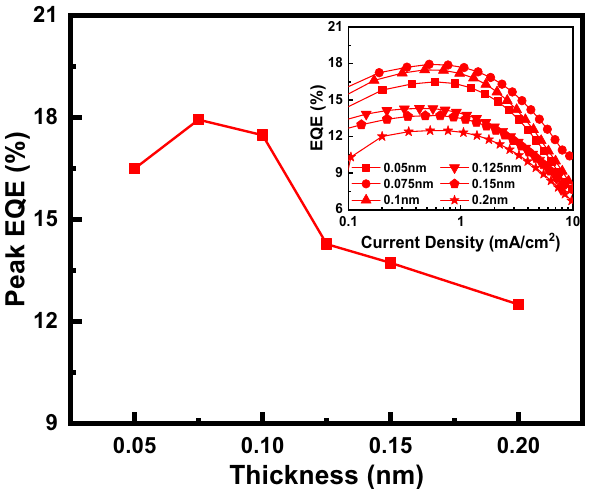
Figure 2. Peak EQE versus thickness of Ir(ppy) 3 from 0.05 to 0.2 nm. The inset shows the EQE characteristics of the fabricated OLEDs, as a function of current